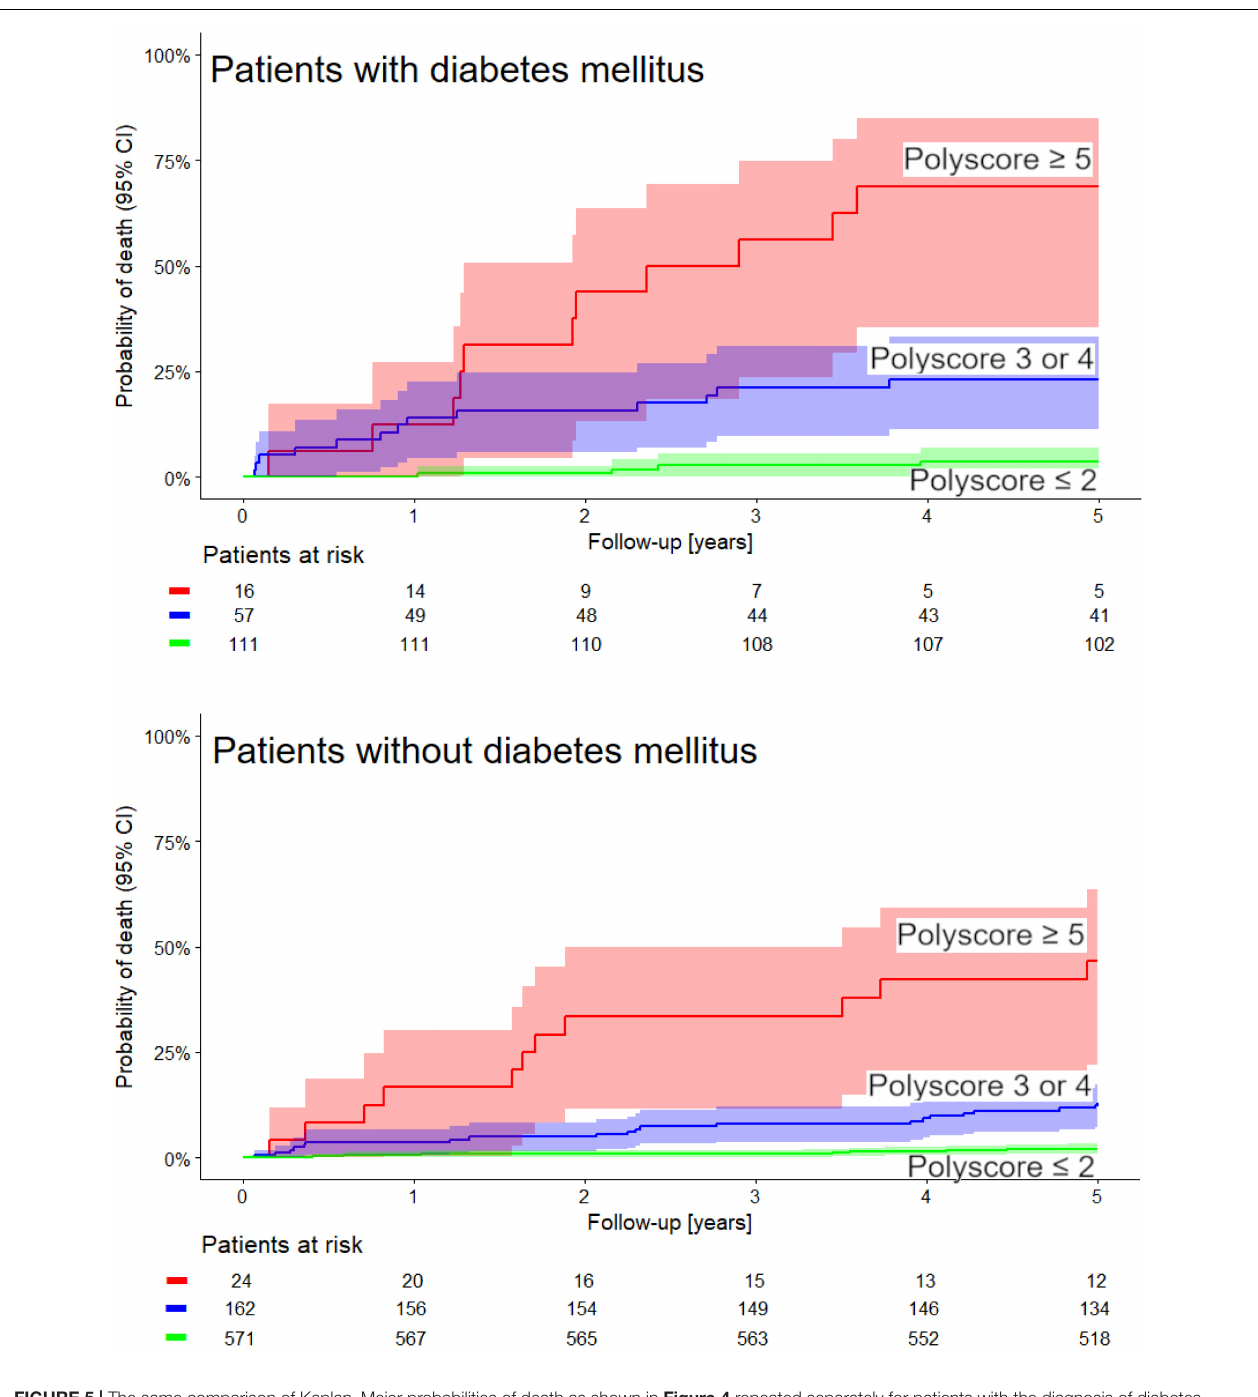
FIGURE 5 | The same comparison of Kaplan–Meier probabilities of death as shown in Figure 4 repeated separately for patients with the diagnosis of diabetes mellitus (top panel) and for patients without the diagnosis of diabetes mellitus (bottom panel). In both cases, the differences between the probabilities of death in these groups was statistically significant ( χ 2 = 59 and χ 2 = 123, respectively, both p < 0.0001). Numbers of patients at risk in the individual sub-groups are shown below the time